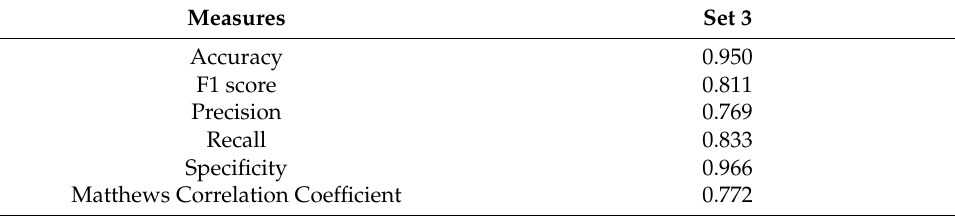
Table 12. Effectivity of the model for recognition of trolls based on lexicon sentiment analysis.